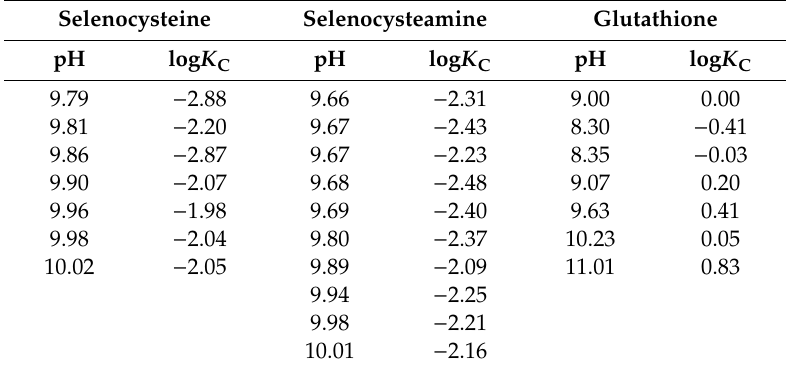
Table 2. The conditional redox equilibrium constants in logarithmic units at the pH indicated in reaction mixtures of dithiothreitol with selenocysteine, selenocysteamine and glutathione. Selenocysteine